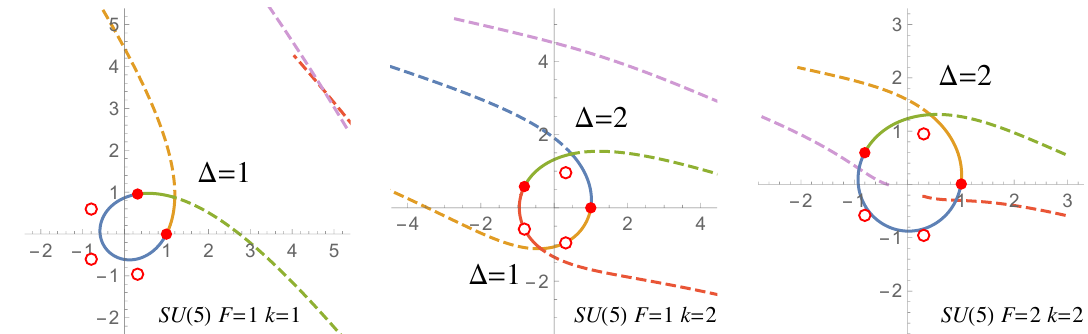
Figure 4: Symmetry preserving k -walls in massive SU ( 5 ) SQCD with F flavors, for some selected values of F and soliton sector k . Conventions are again as in Figure